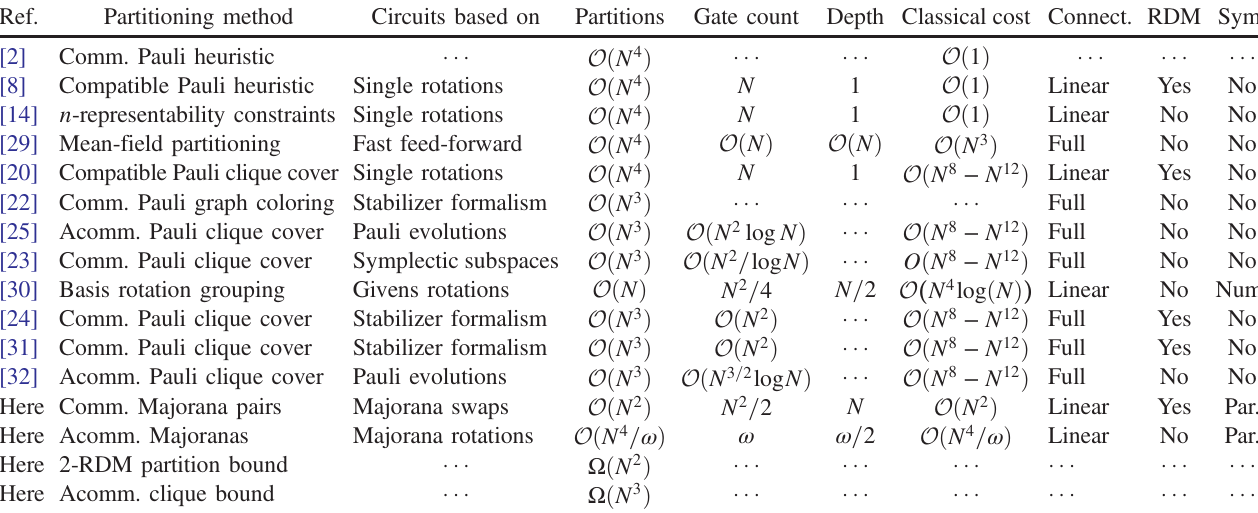
TABLE I. A history of ideas reducing the measurements required for estimating the energy of arbitrary basis chemistry Hamiltonians with the variational quantum eigensolver. Here, N represents the number of spin orbitals in the basis, and ω is defined in the text. We use the shorthand “ comm. ” and “ acomm. ” for commuting and anticommuting, respectively. The “ partitions ” column counts the number of unique circuits required to generate at least one sample of each term in the Hamiltonian. Gate counts and depths are given in terms of arbitrary one- or two-qubit gates restricted to the geometry of two-qubit gates specified in the connectivity column. The “ classical cost ” column reports the overhead to determine the partitions for a given Hamiltonian. In the “ RDM ” column we report whether the technique is able to measure the entire fermionic 2-RDM with the stated scaling, or just a single expectation value (e.g., of the Hamiltonian). In the “ sym. ” column we report whether any symmetries of the system commute with all measurements made. Here, “ Num. ” refers to the number operator, and “ Par. ” the global fermion parity. When these operators commute with the given measurements they may be simultaneously measured, enabling strategies for error mitigation by postselection at zero additional cost.